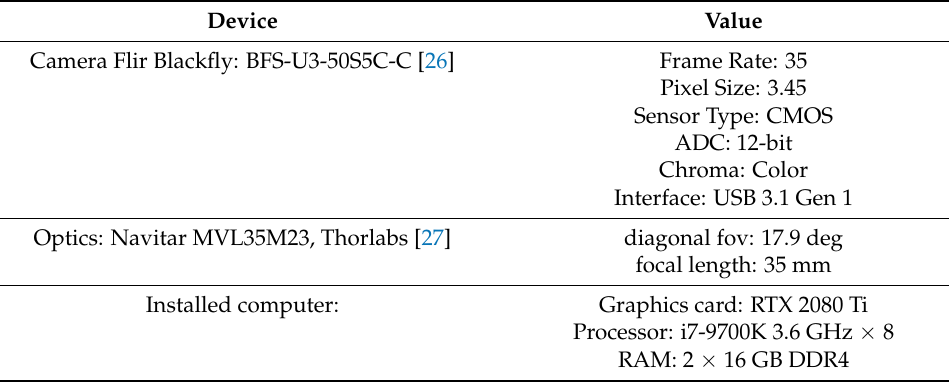
Table 3. Detailed hardware